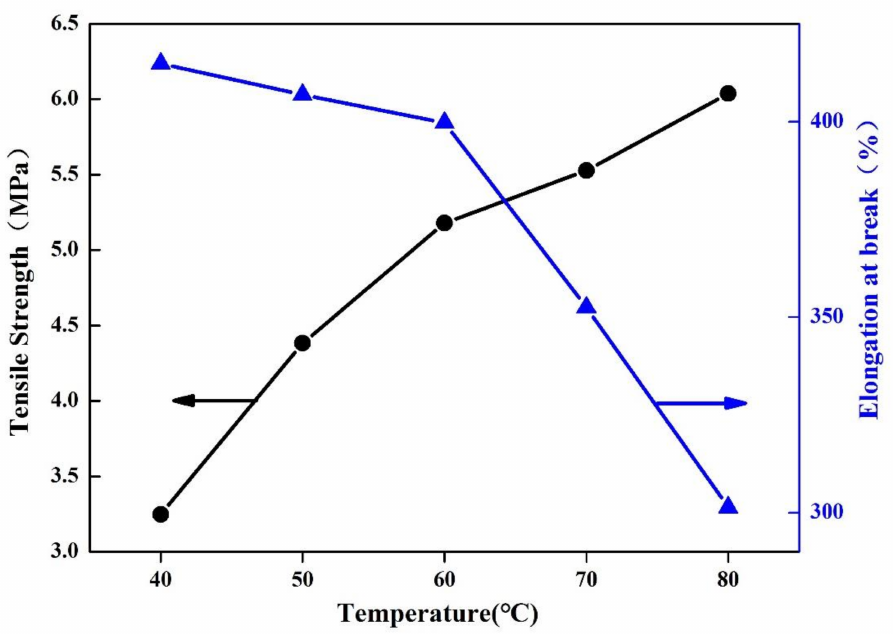
Figure 18. Mechanical properties of SPU films with different film forming